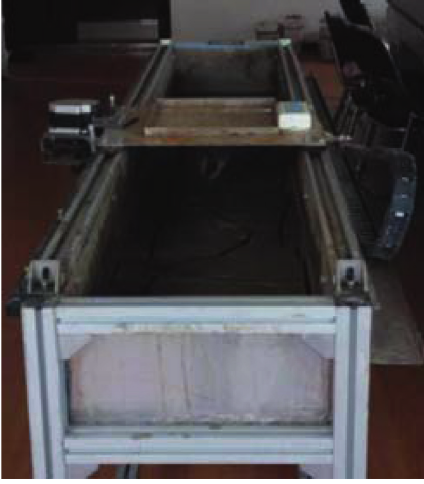
Figure 16: The test soil bin. Table 2: Test results of traction resistance of floating